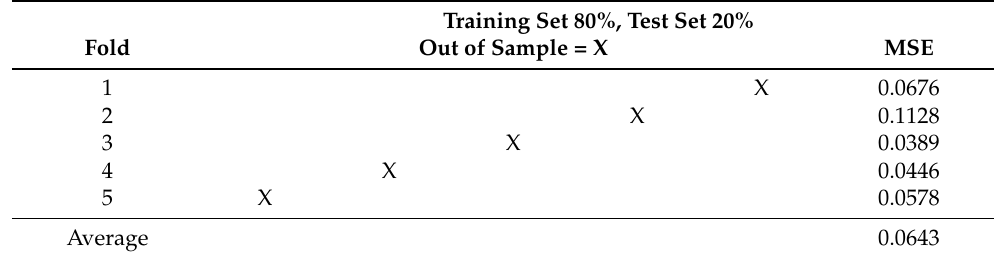
Table 1. Performance of the CNN on the individual folds. The MSE was calculated for the out-of- sample subset using the smallest MSE (early